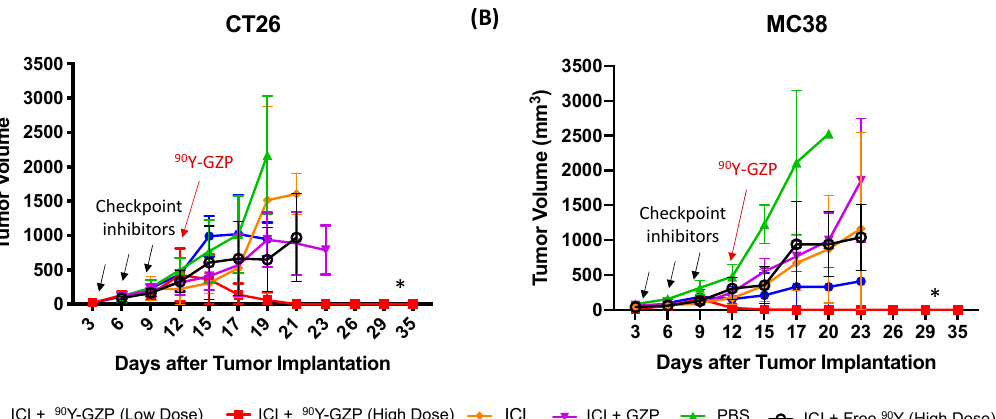
Figure 2. Tumor growth curves of ( A ) CT26 and ( B ) MC38 tumor-bearing mice after administration of the different therapeutic groups. Checkpoint inhibitors were given days 3, 6 and 9 after tumor implantation and 90 Y-GZP was given on day 12 (indicated by arrows). High dose of 90 Y-GZP (22.2 MBq) after ICI achieved complete tumor response in both tumor models. * Statistically significant compared to all other groups ( p < 0.05).